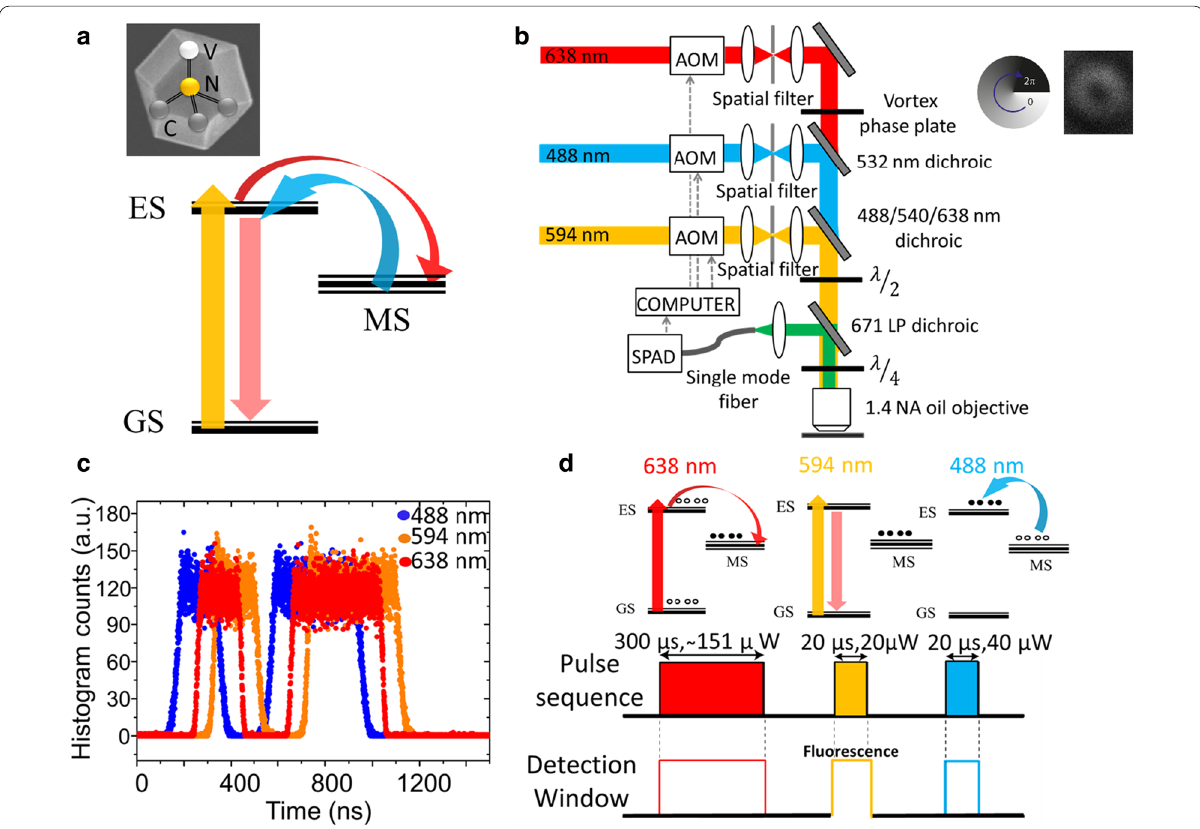
Fig. 1 a Principle of the GSD in NV − in NDs using a probe beam at 594 nm (yellow), a depletion beam at 638 nm (red) and a reset beam at 488 nm (blue). GS ground state, ES excited state and MS metastable state of the NV centre. Illustration of an NV centre in a nanodiamond. b Schematic representation of the experimental set-up. The system consists of a home-built confocal microscope with three lasers operating at the wavelengths of 488 nm, 594 nm and 638 nm. A vortex phase plate spatially engineers the 638 nm depletion beam into a donut beam to ensure depletion only around the diffraction limited area. c Characterisation of acousto-optic modulators by measuring the pulse arrival times of each laser. d Schematic of the pulse sequence used in GSD nanoscopy. The detection window is synchronised to the probe beam at 594 nm to collect only relevant fluorescence. The pulse length of the 594 nm probe beam was optimised at 20 μs, as a shorter pulse length would result in longer averaging times and longer pulse lengths would lead to less efficient super-resolution imaging. The 488 nm reset beam was optimised at 20 μs as it is preferable to have it as short as possible to reduce the overall pulse sequence time but still empty the long-lived metastable state